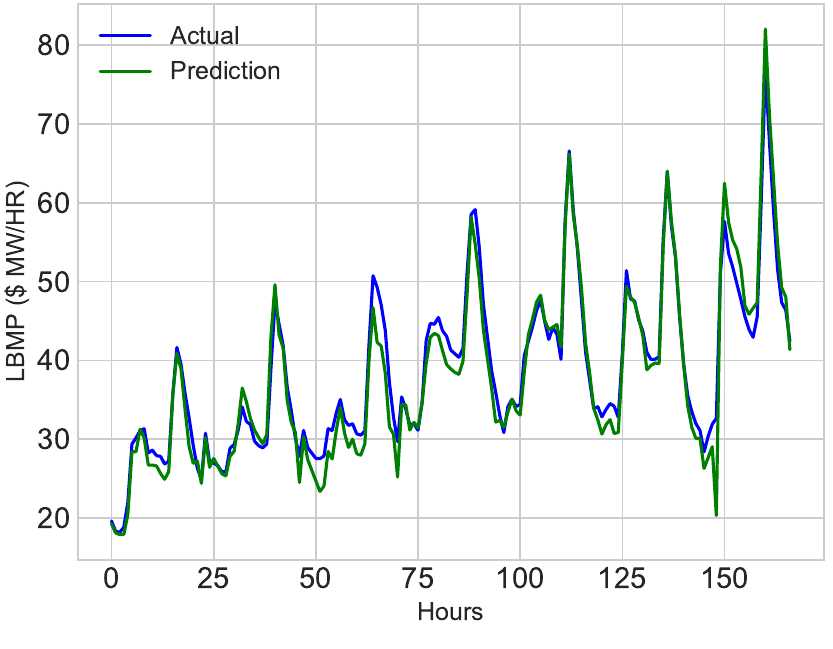
Figure 19. First Week of January, 2017.